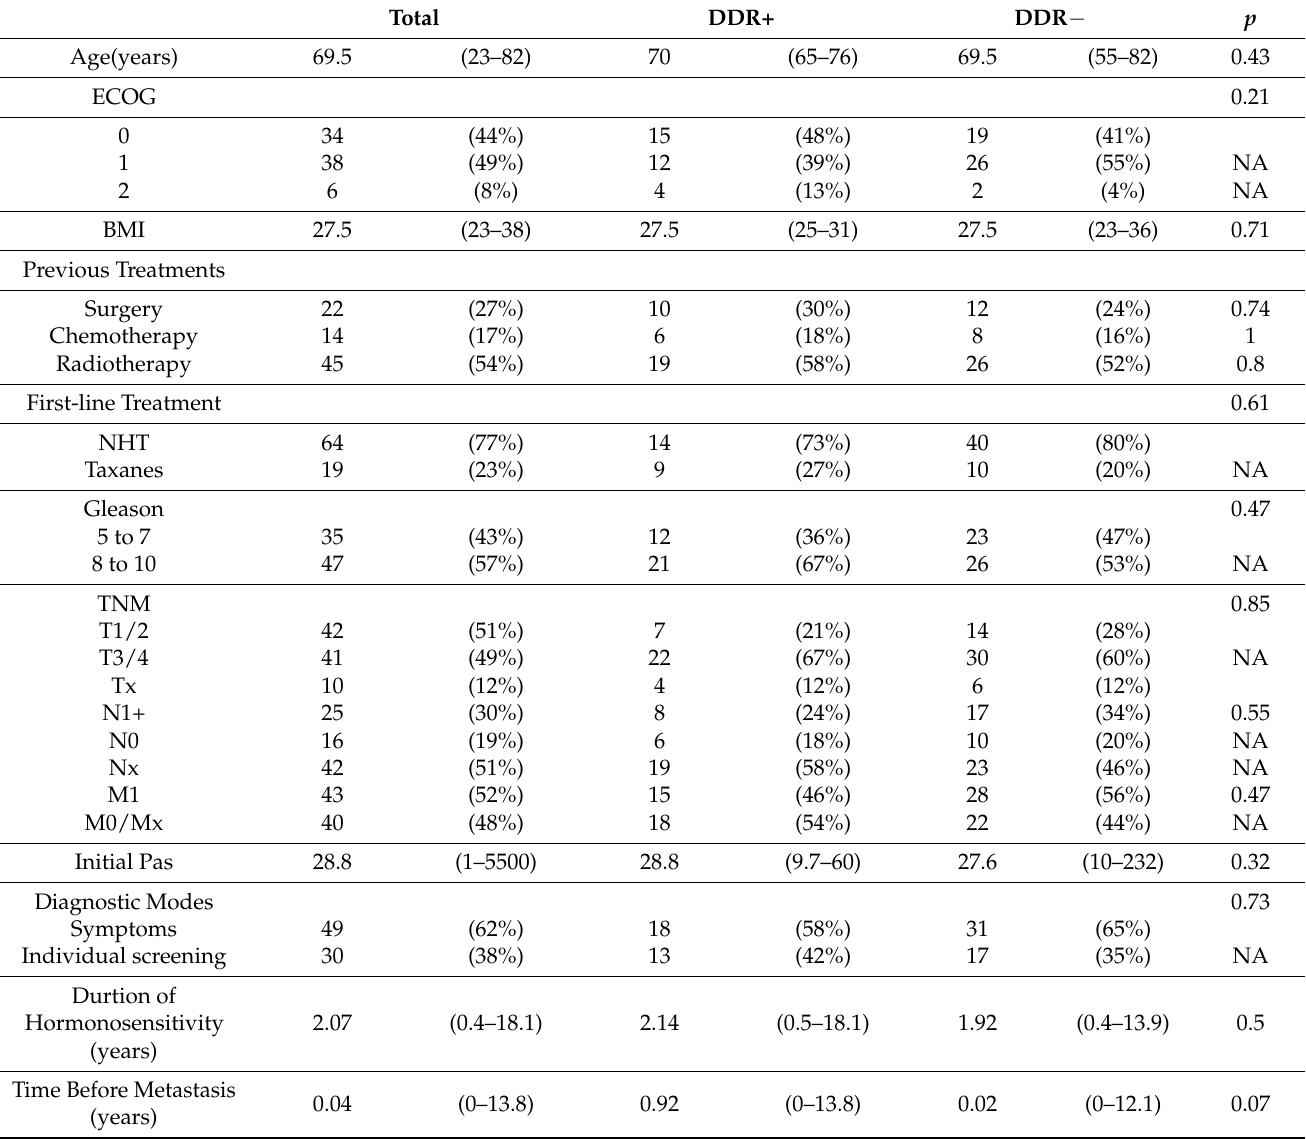
Table 1. Clinical outcomes of analyzed patients according to somatic DDR+ vs. DDR −